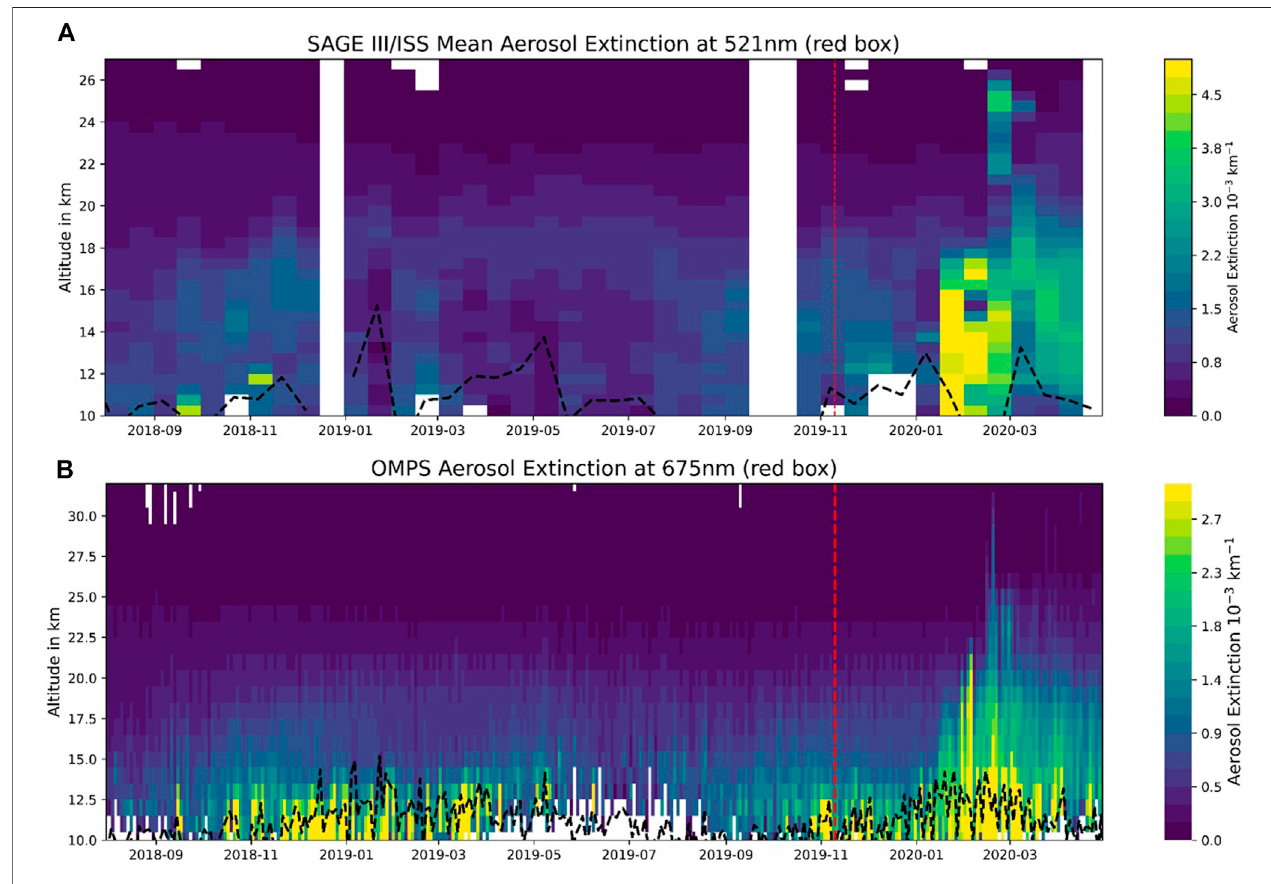
FIGURE 6 | (A) SAGE III/ISS 15-day mean Aerosol extinction values at 521 nm over the region 160 – 175 ° E, 32 – 58 ° S (red box, as indicated in Figure 3 ). The red vertical, dashed line represents the time of the observed enhanced CO values from Figure 3 . The black dashed line represents the average tropopause altitude. (B) OMPS 2-day mean Aerosol extinction values at 675 nm for the red